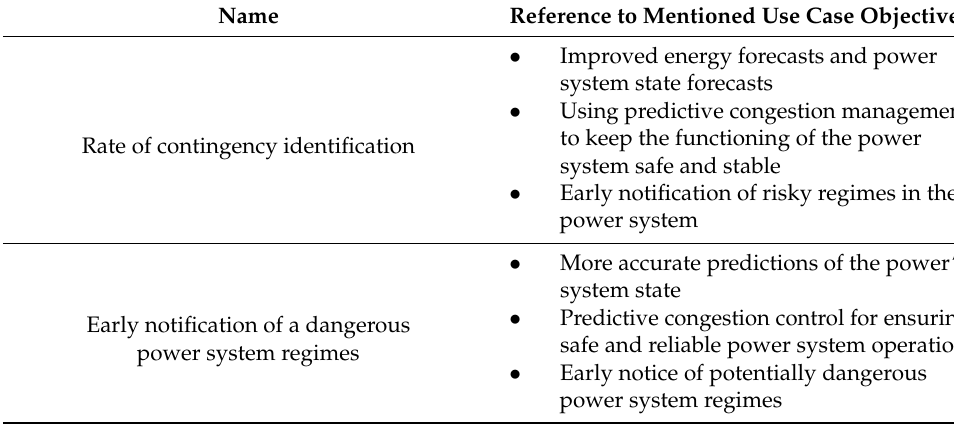
Table 7. Key performance indicators for SUC